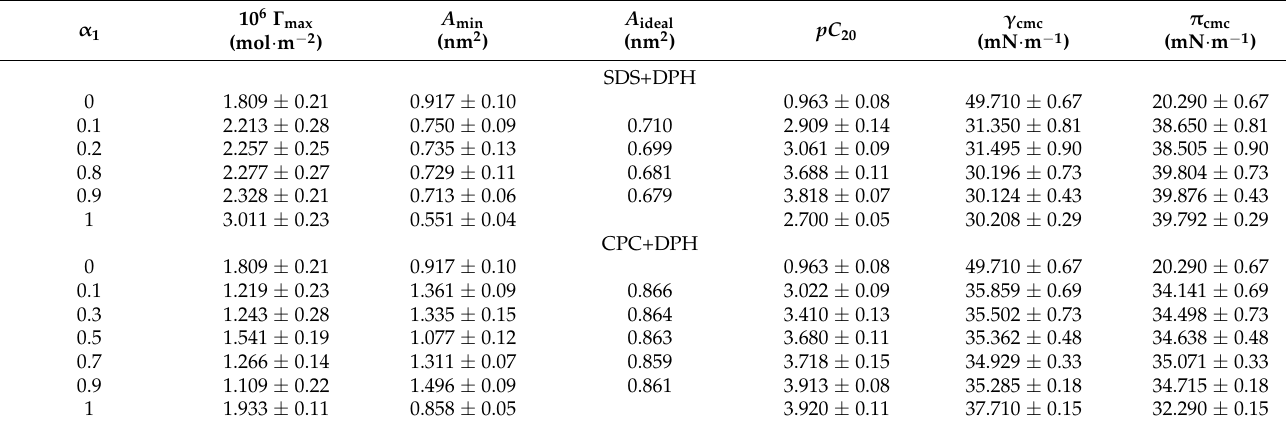
Table 2. Surface parameters of DPH and SDS/CPC mixed systems at temperature T = 298.15 K. Values are the mean ± SD ( n = 3). α 1